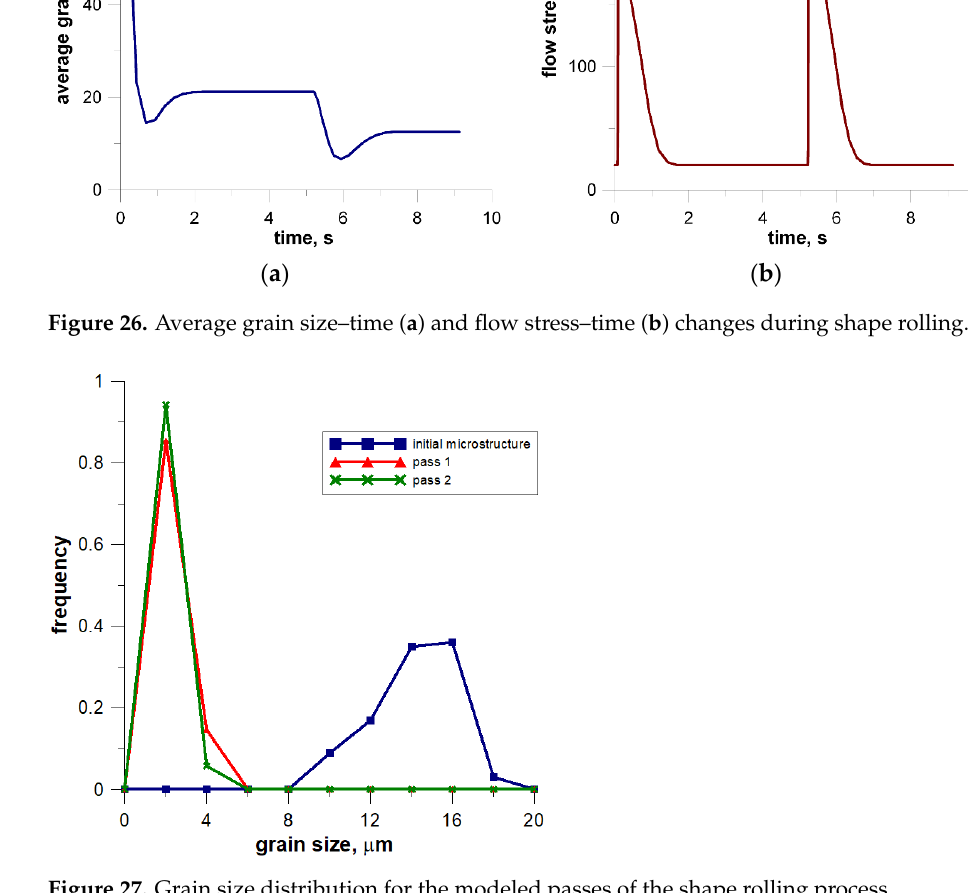
Figure 27. Grain size distribution for the modeled passes of the shape rolling process.